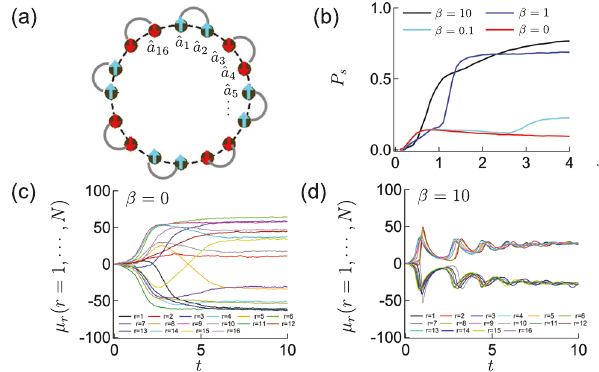
Fig. 3 Frustrated lattice and impact of amplitude control. a N = 16 one- dimensional ring with nearest-neighbor and next-nearest-neighbor antiferromagnetic coupling. Sites with blue and red arrows show up-spin ( σ = 1) and down-spin ( σ = − 1) states respectively. The pairs of two same sign spins under antiferromagnetic coupling are shown with gray lines. b Success probability as the function of coupling coef fi cient j with various β . c , d Time evolution of mean amplitudes without ( β = 0) and with amplitude control ( β = 10).